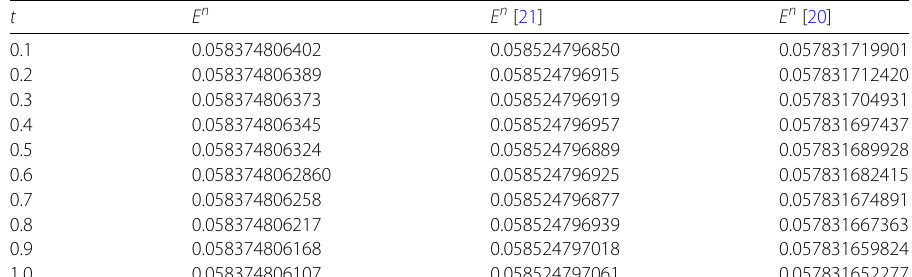
Table 2 Discrete energy values at h = τ = 0.02